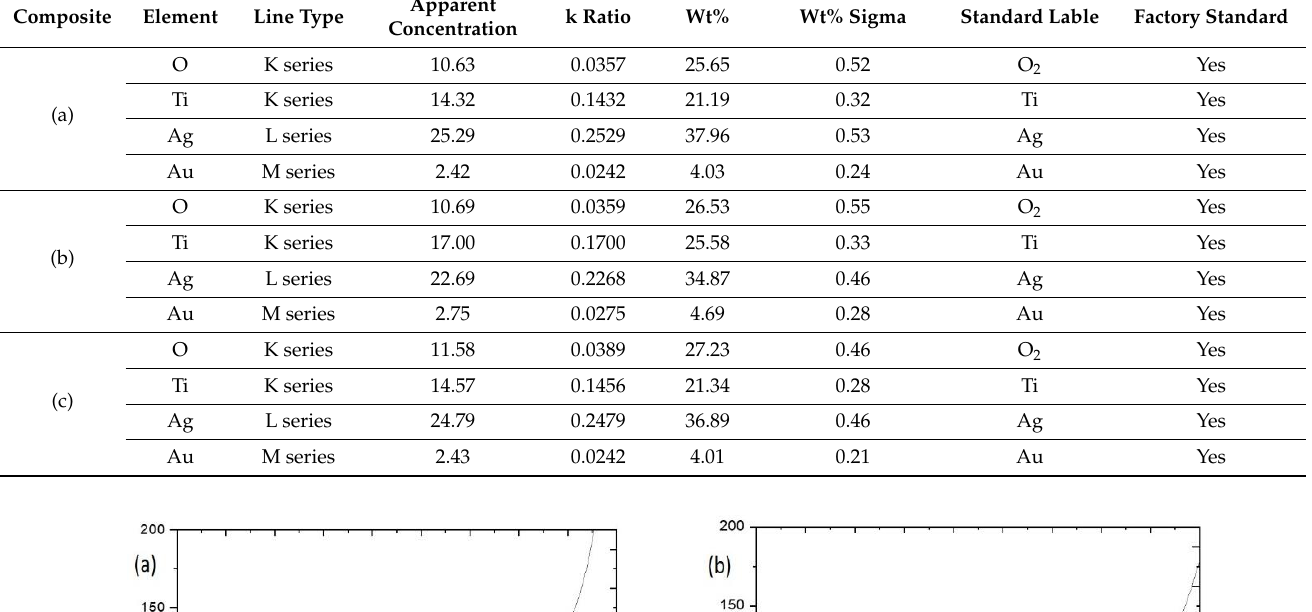
Table 1. The elemental composition of ( a ) 0.5 Ag/TiO 2 composite; ( b ) 0.01 Ag/TiO 2 composite; ( c ) 0.1 Ag/TiO 2 composite.